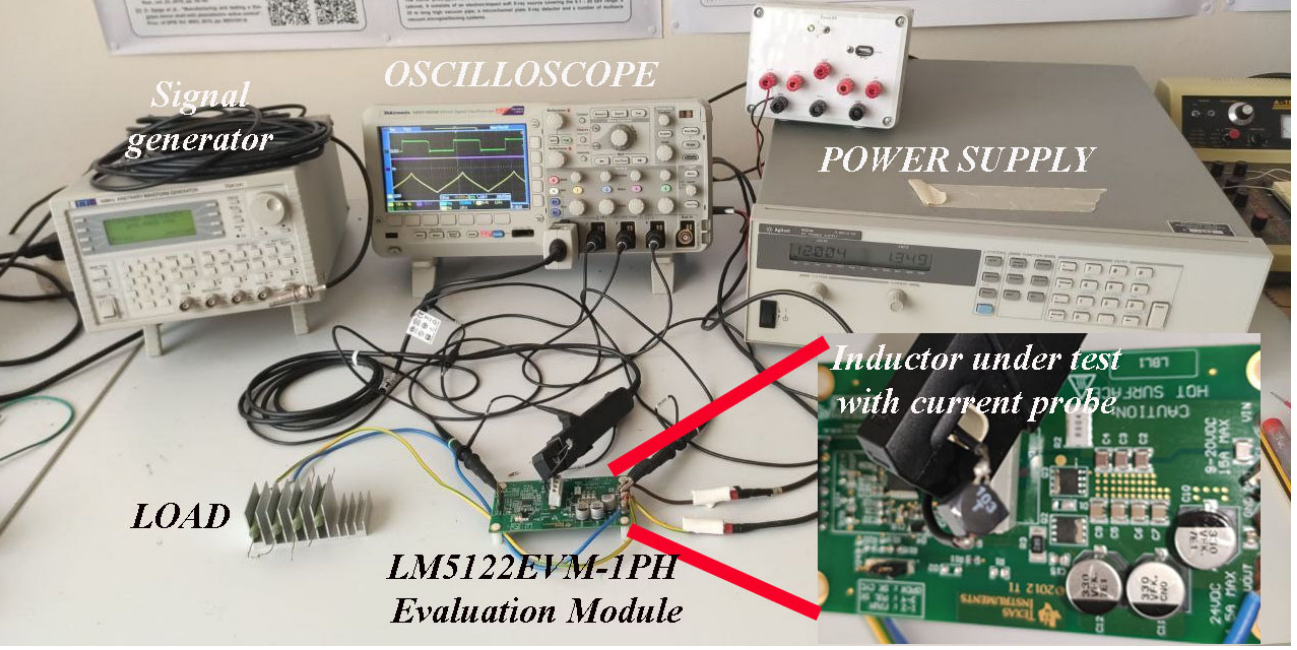
Figure 5. Test rig used for measurements and characterization.